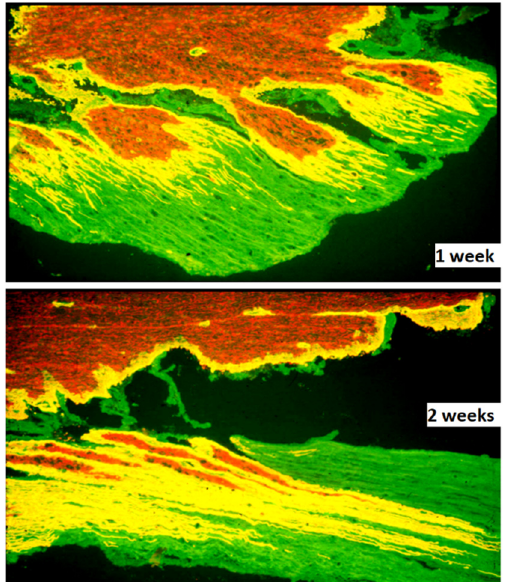
Figure 2. Lumbar dorsal roots following ipsilateral dorsal root injury. Horizontal sections, immunostained with antibodies to laminin (green) and GFAP (red). The extensive outgrowth of astroglial processes (red and yellow) into the peripheral compartment is shown at one week (above) and two weeks (below) following injury. ×200. Reproduced from ref [35].